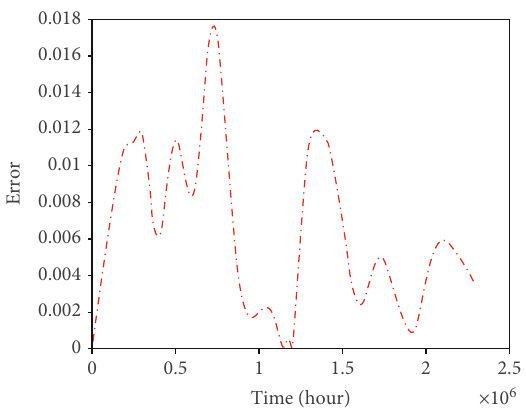
Figure 15: The error between the analytical function and the regression